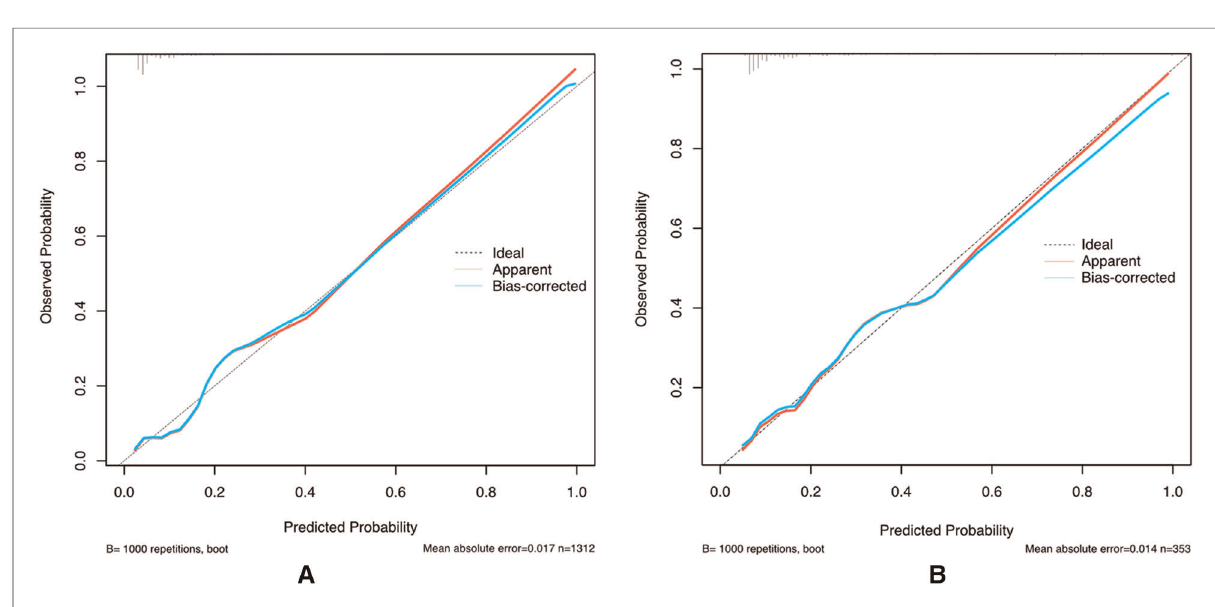
FIGURE 4 Calibration plot for the prediction model in the derivation and validation